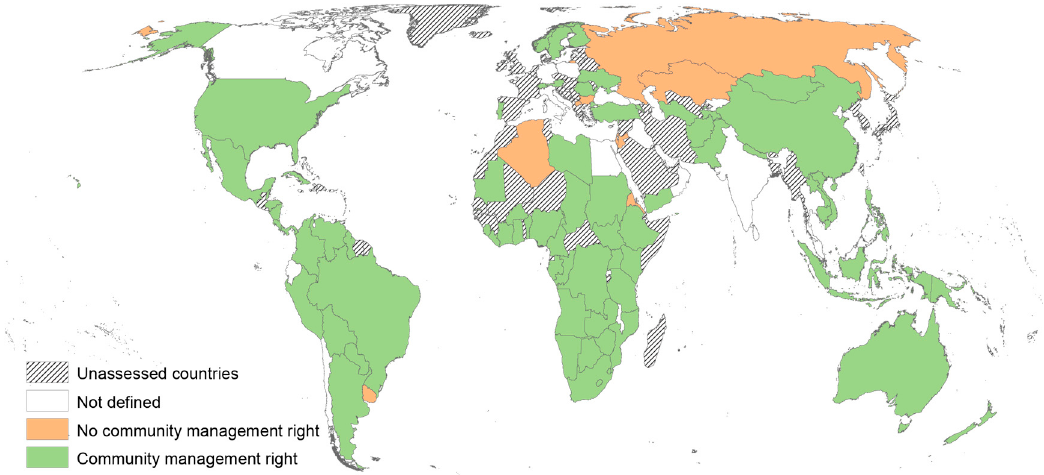
Figure 6. Legal recognition of community water management.